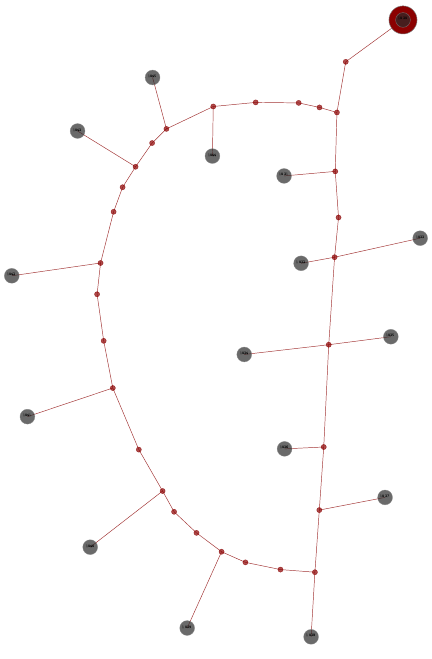
Figure 12. Representation of the graph before network